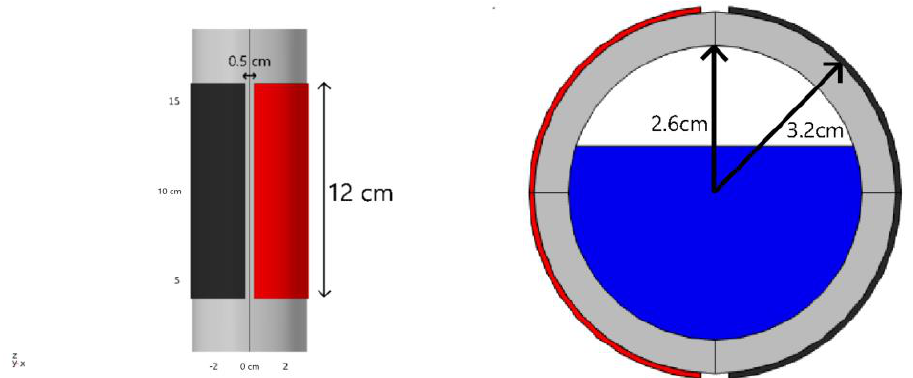
Figure 8. Simulated concave sensor along with its dimensions with the stratified two-phase flow where the blue color represents water level, the gray color represents the of the pipe, and the red and black colors represent the electrodes.